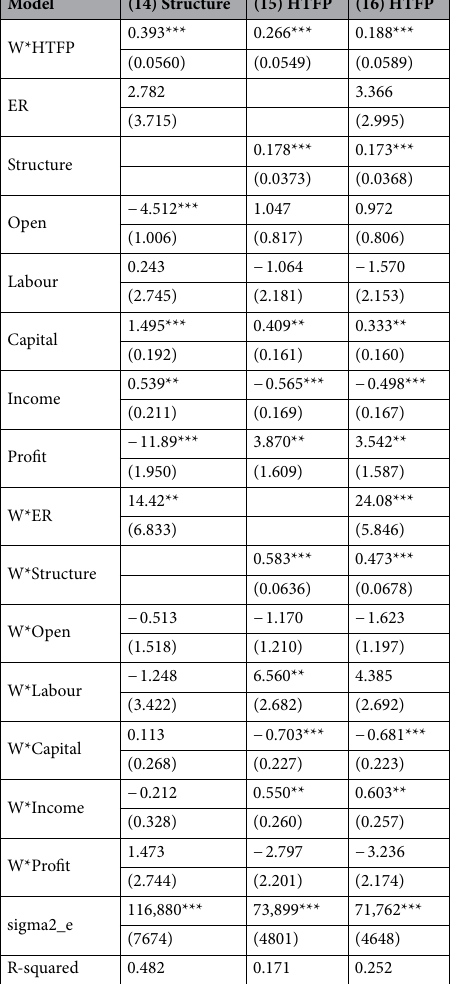
Table 8. Mediating effects of industrial structure. *, **, ***indicate significance at the 10%, 5% and 1% level, and the standard errors are in